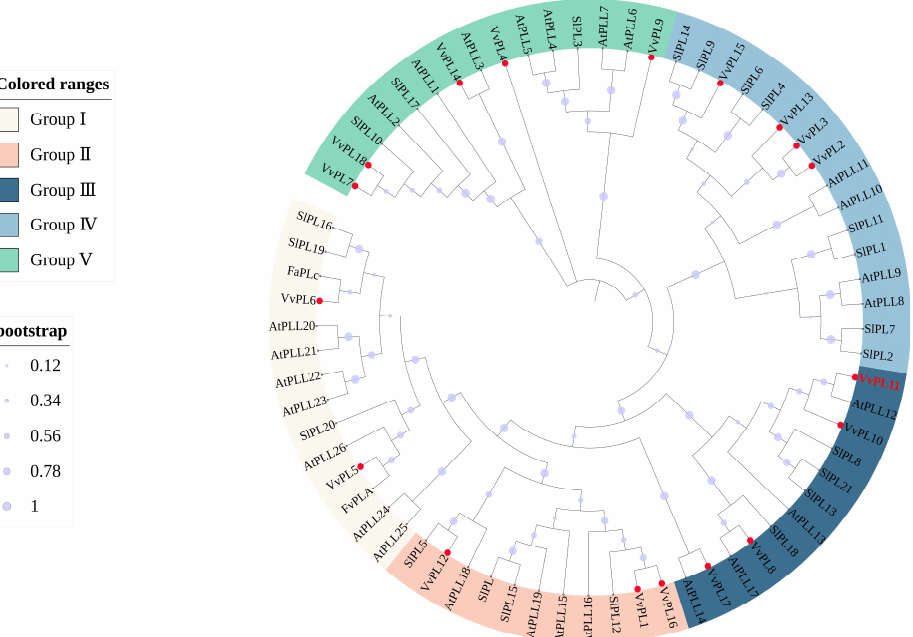
Figure 2. Phylogenetic tree of pectin lyase (PL) proteins from grapevine and other species. The pro- teins clustered into five groups, which were labeled with different colors at the periphery. Grapevine proteins were labeled with red dots. The species shown are Arabidopsis thaliana (At), Vitis vinifera (Vv), Solanum lycopersicun (Sl), Fragaria ananassa (Fa), and Fragaria vesca (Fa).